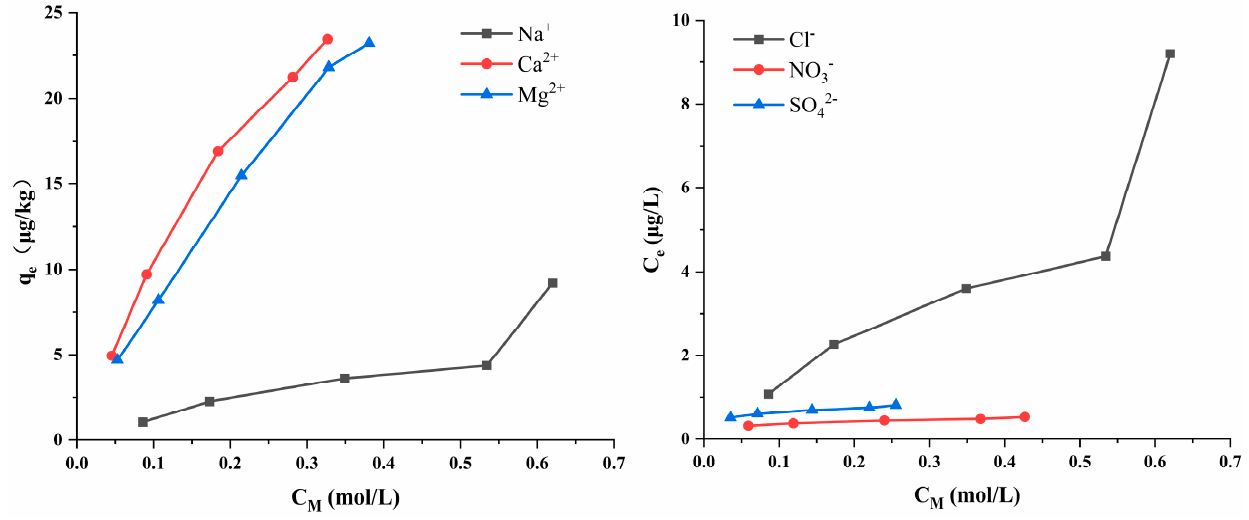
Figure 4. Mean amounts of Cd released ( q e ) at different molar concentrations ( C M ) of different ions.